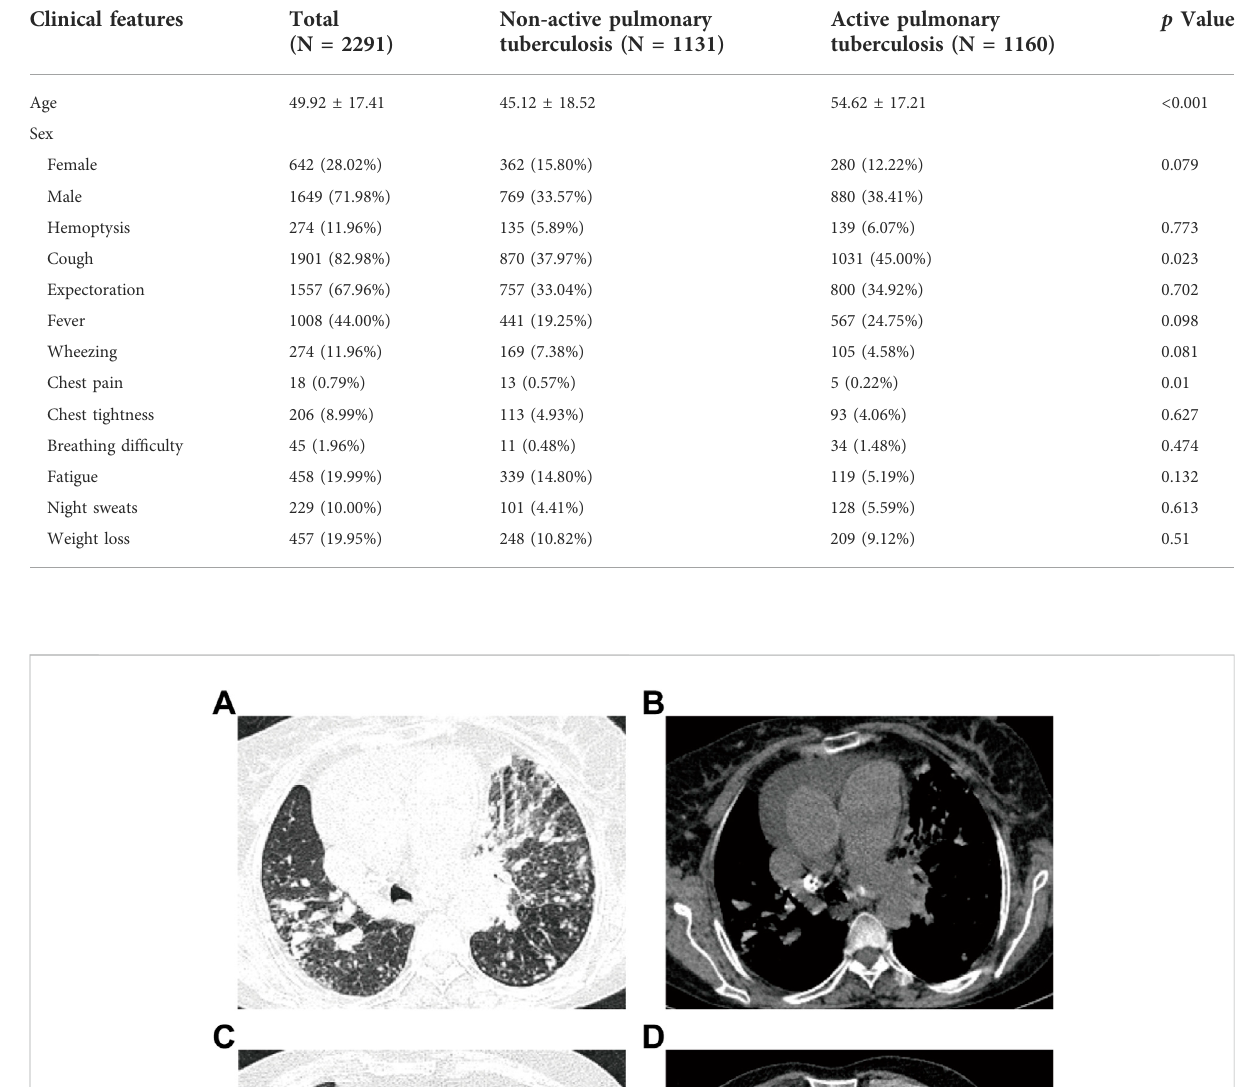
TABLE 1 Baseline characteristics of the 2291 patients.